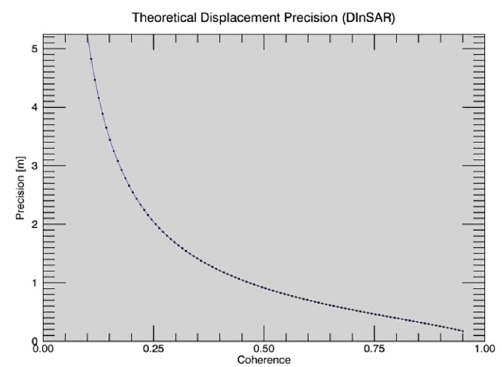
Figure 4. Theoretical displacement precision of DInSAR.